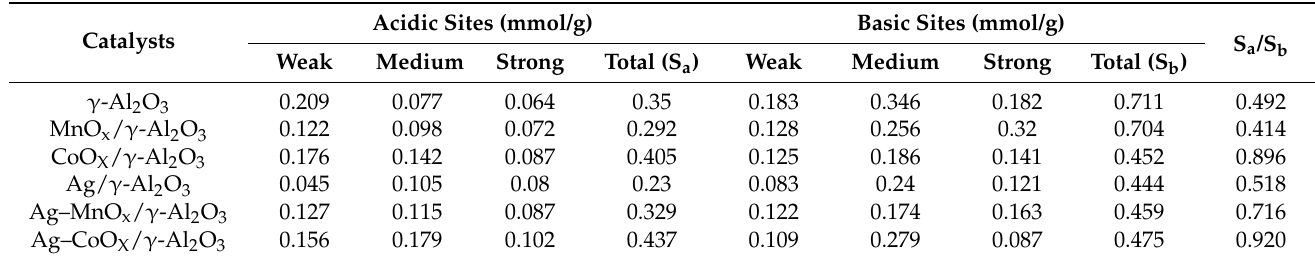
Table 2. A comparison table of acidic and basic sites of freshly prepared